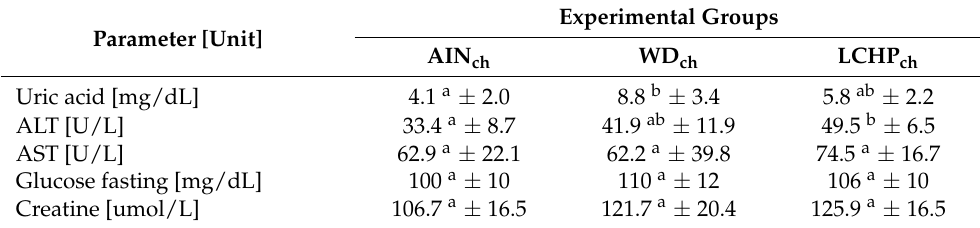
Table 4. The concentration/activity of examined biochemical parameters in blood of rats after 8 weeks of feeding: AIN ch , WD ch (Western diet) or LCHP ch (low-carbohydrate–high-protein) diets, enriched with 1%